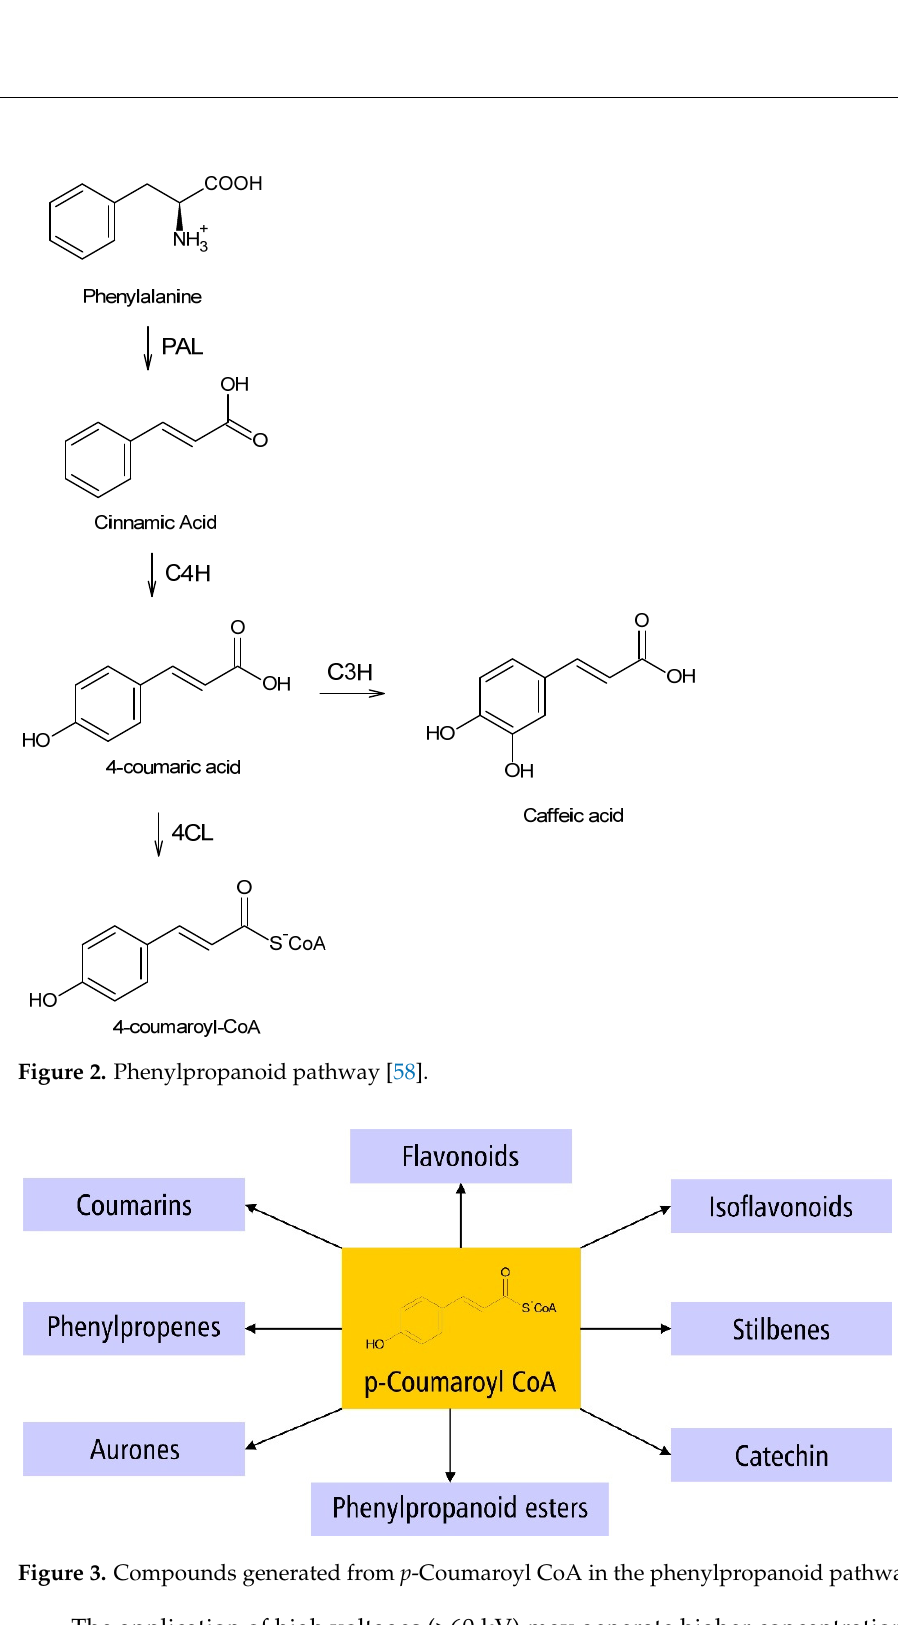
Figure 3. Compounds generated from p -Coumaroyl CoA in the phenylpropanoid pathway [81].